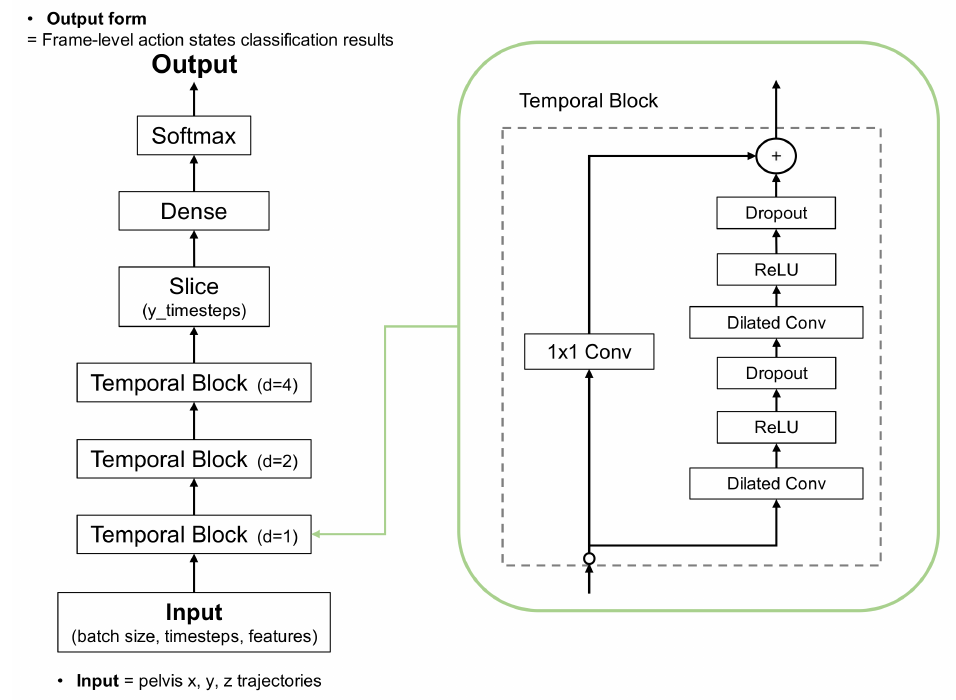
Figure 4. Architecture of dilated temporal convolutional network